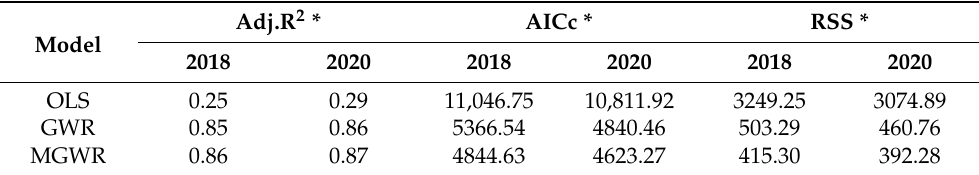
Table 3. Comparing the OLS, GWR, and MGWR model fits.